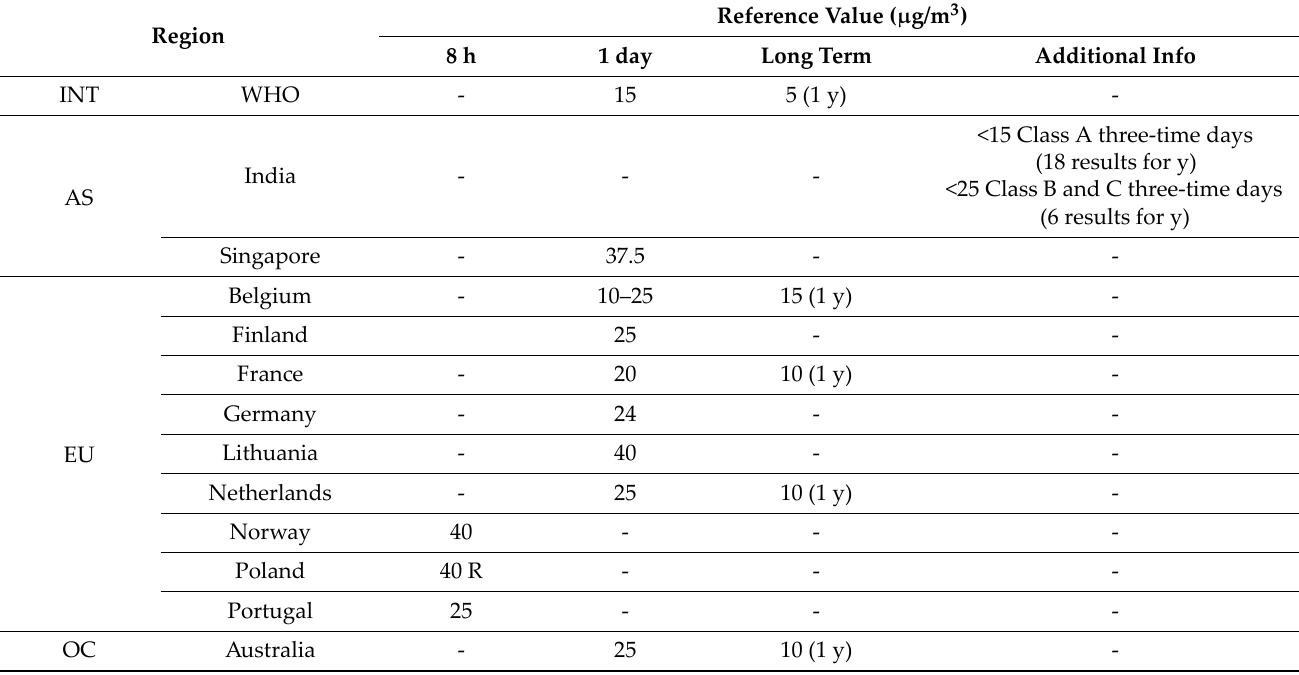
Table 13. Reference values for PM 2.5 .